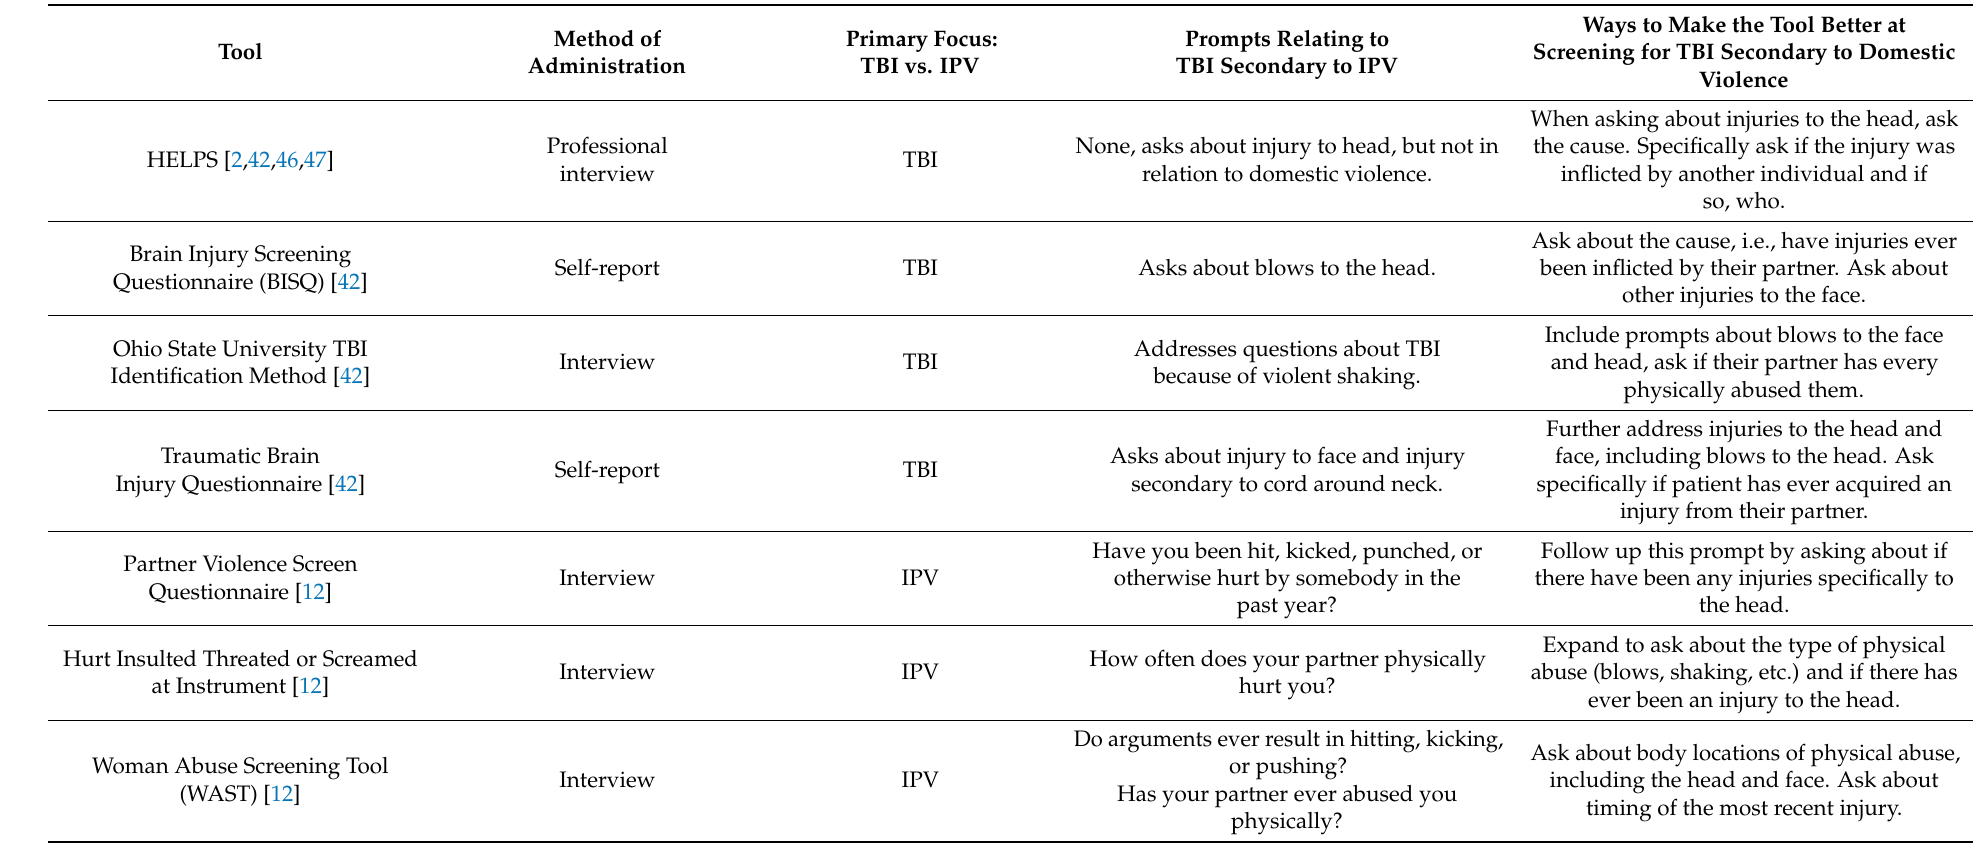
Table 4. Screening tools that help identify TBI secondary to domestic